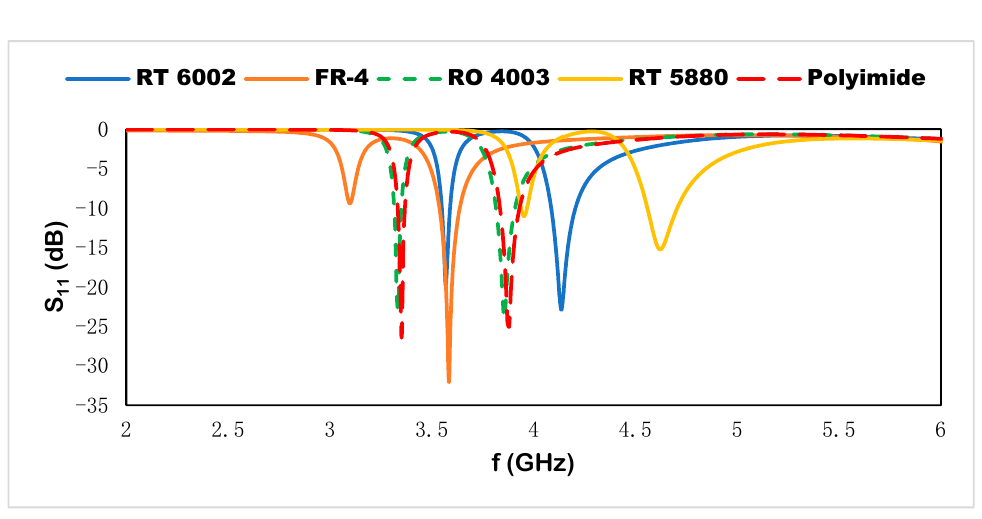
13 of 19 Figure 11. Simulated result and measured results of the reflection coefficient. 5. Parametric Analysis Different dielectric substrates are utilized to observe the scattering properties such as reflection coefficient for Rogers RT 6002, FR-4, Rogers RO 4003, Rogers RT 5880, and pol- yimide, where the corresponding results are shown in Figure 12. The FR-4 substrate as the host medium exhibits two resonant frequencies at 3.11 and 3.6 GHz with depth notches at − 9.4 and − 32, respectively, which are shown in Table 3. The higher dielectric constant is responsible for the variation in polarization state for the applied electric field component.